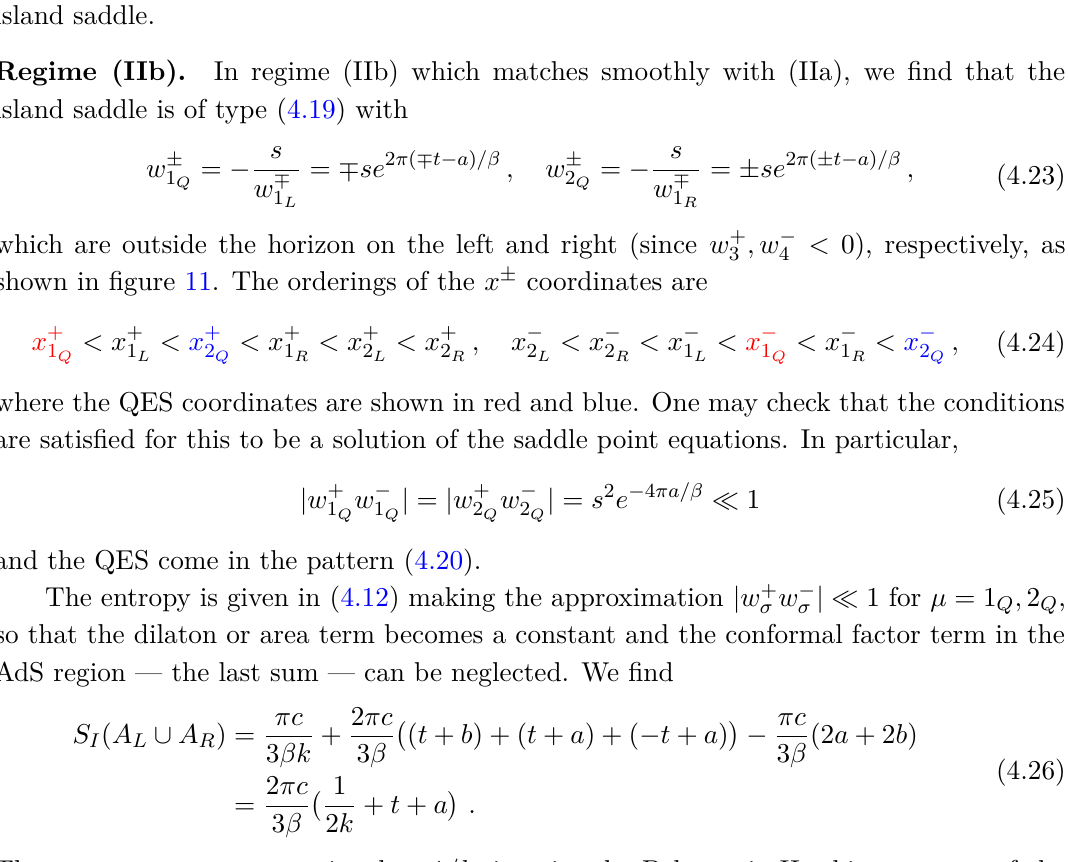
Figure 11 . The island saddle in regime (II) has an island with QES that can move from inside to outside the horizon (when 2 a < 1 ( b − a ) ) as shown in red and blue. If 2 a > 1 2 inside the horizon. The labelling of points along a Cauchy slice are shown and only the upper half of the Penrose diagram in figure 2 is